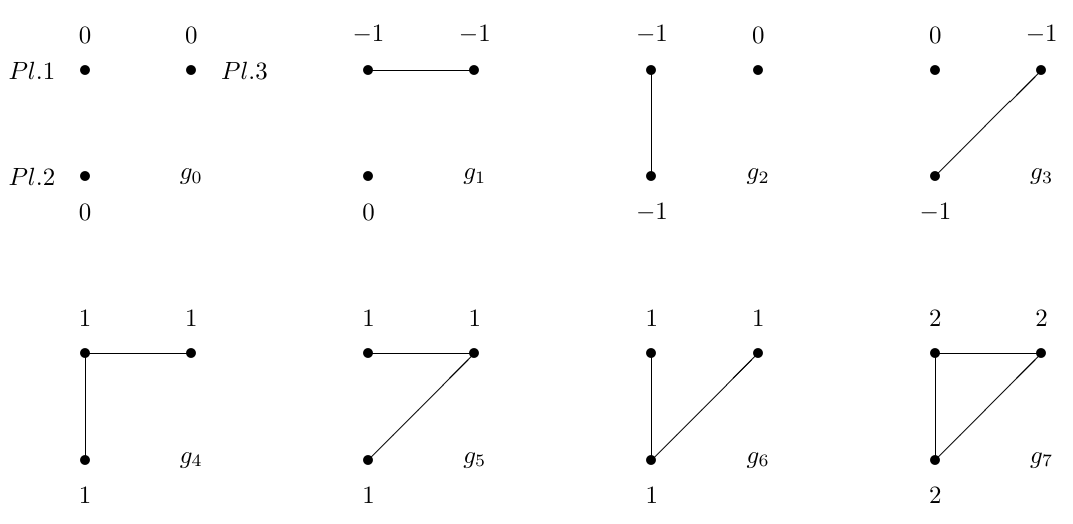
Figure 1. An example with three